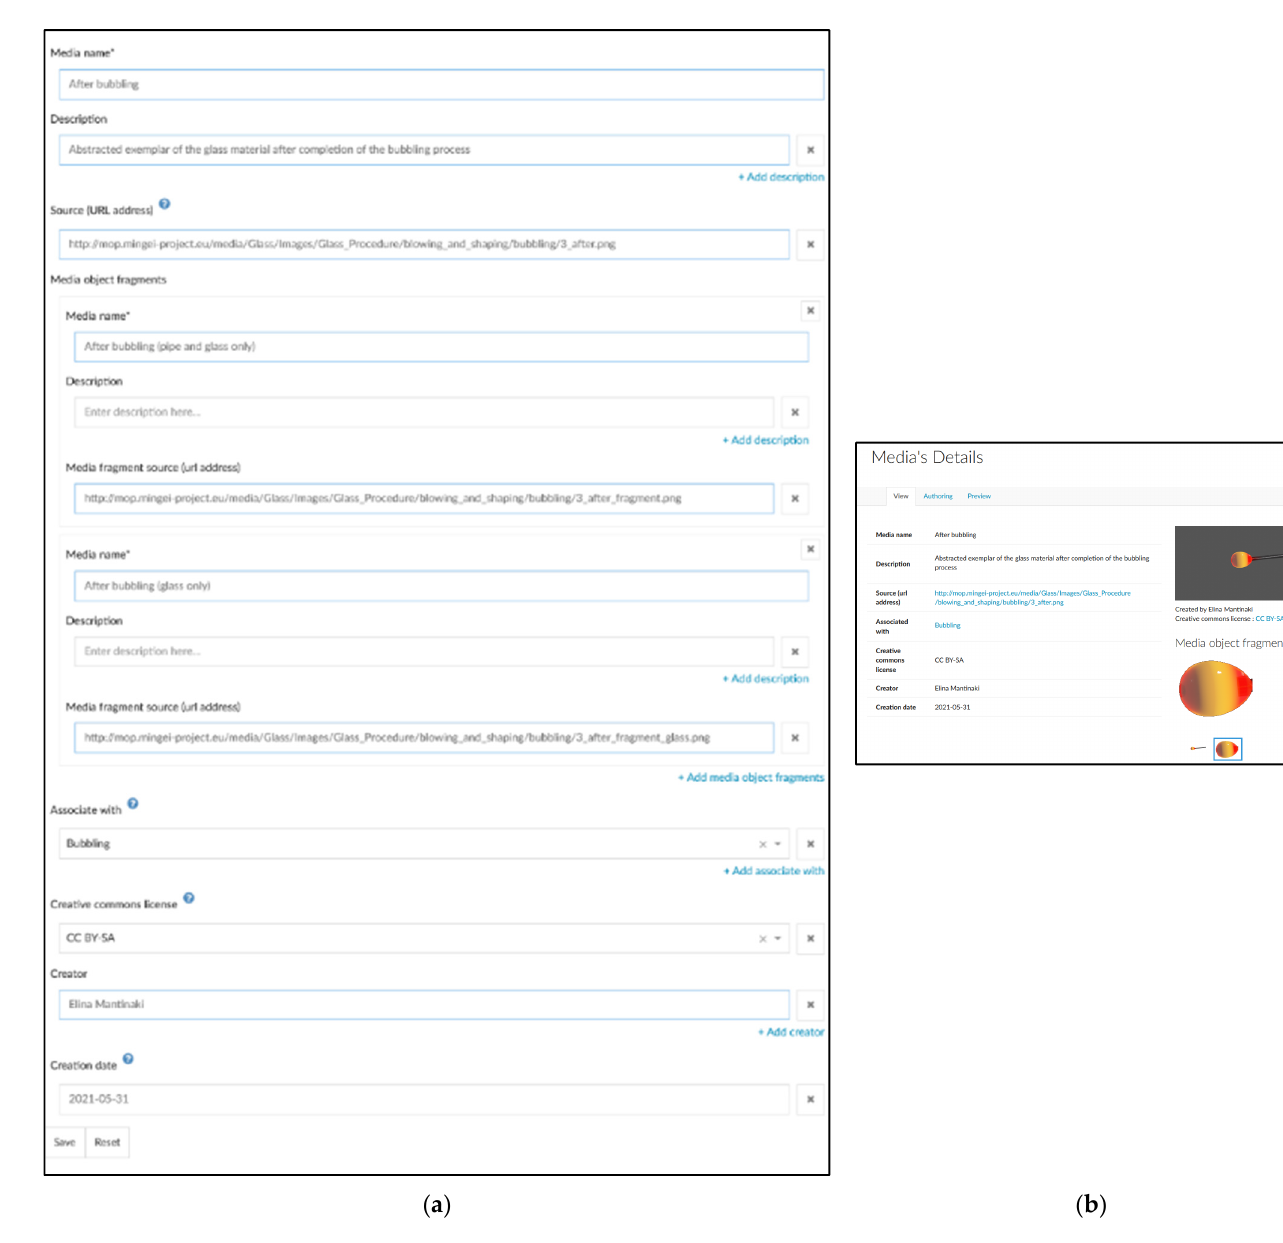
Figure 2. ( a ) Data curation of Media objects, ( b ) Media object preview.